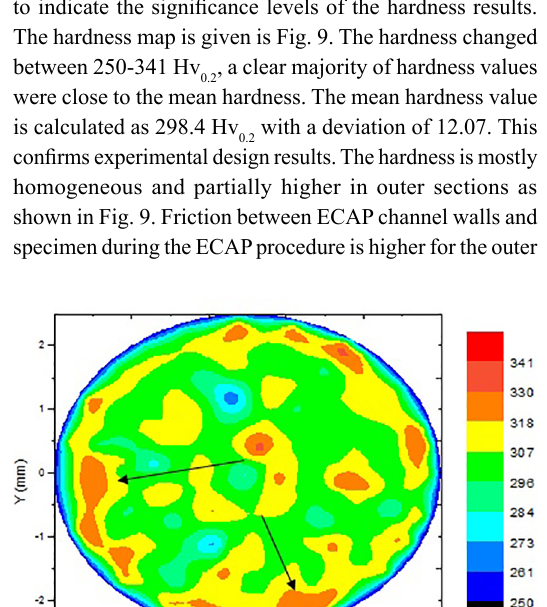
Fig 8 d) of the peak decreased. According to the XRD counts the height was 650 for 8 times pressed sample and it was 550 for initial state. The peak width decreased to 0.0587° from 0.0871°. Some peaks heights decreased as shown in Fig. 8 103c which is the nature of SPD. During SPD procedure some of the grain can be stress relief due to thermal stress induced recovery and deformation plane direction. After determination of optimal experimental set a more detail hardness map observed with 85 different hardness measurement points and the results were given in Fig. 9. The colour scale is given on the right of the graph in order to indicate the significance levels of the hardness results. The hardness map is given is Fig. 9. The hardness changed between 250-341 Hv , a clear majority of hardness values 0.2 were close to the mean hardness. The mean hardness value